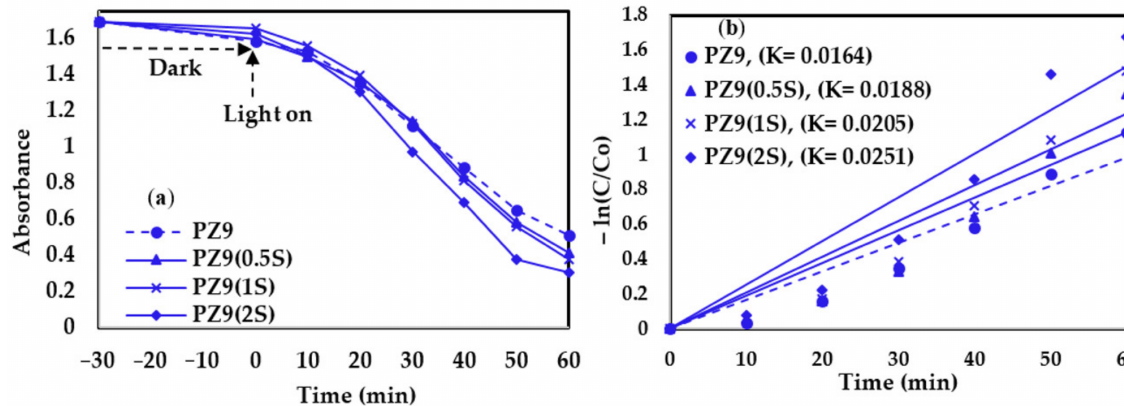
Figure 11. Photocatalytic degradation performance of various PZ9 fibers under visible light irradiation: ( a ) absorbance against time, and ( b ) ln(C/C 0 ) against time (R 2 of approximation: 0.89–0.92).